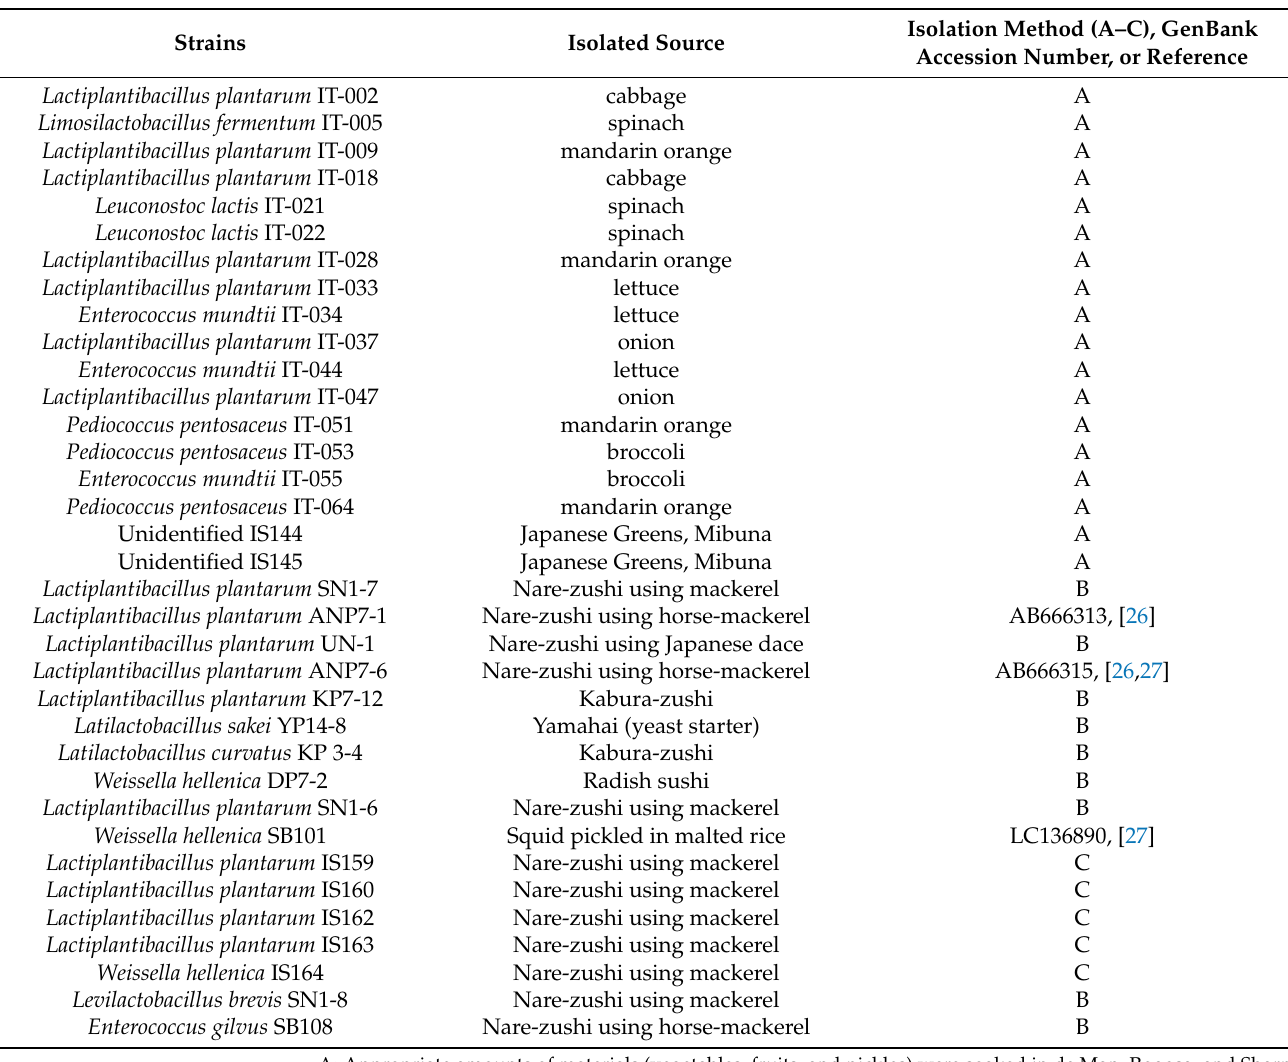
Table 1. List of strains for the screening of polyamine-producing